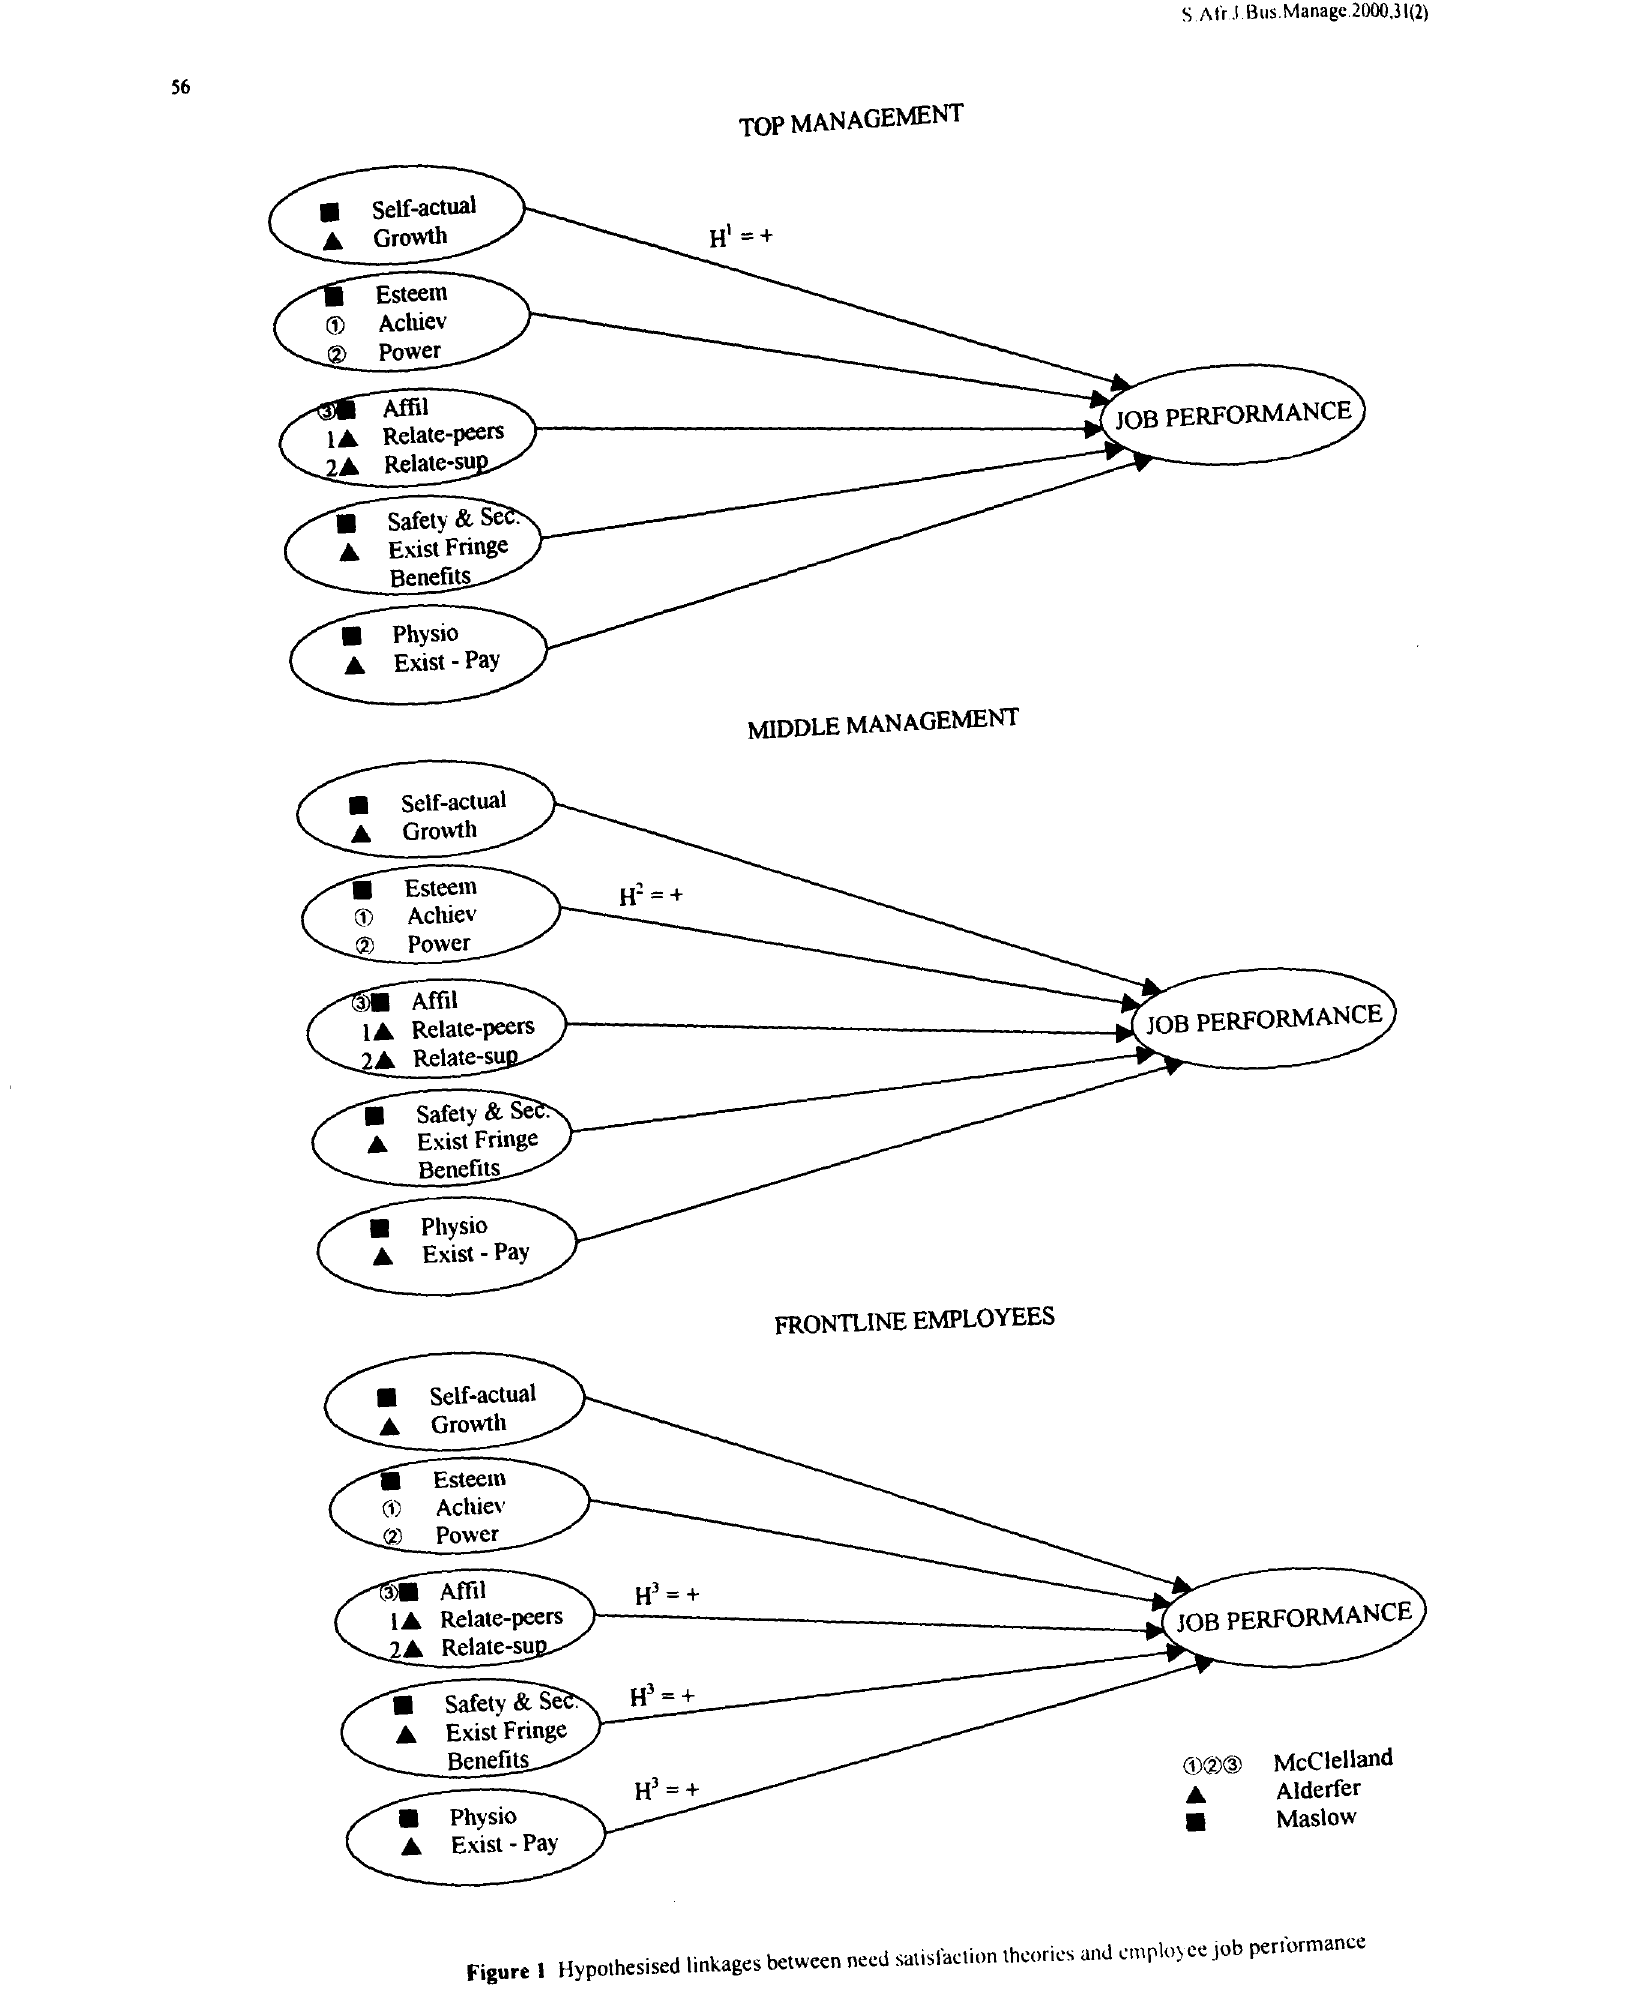
Figure 1 Hypothesised linkages between need satisfaction theories an<l cmplo)ee job